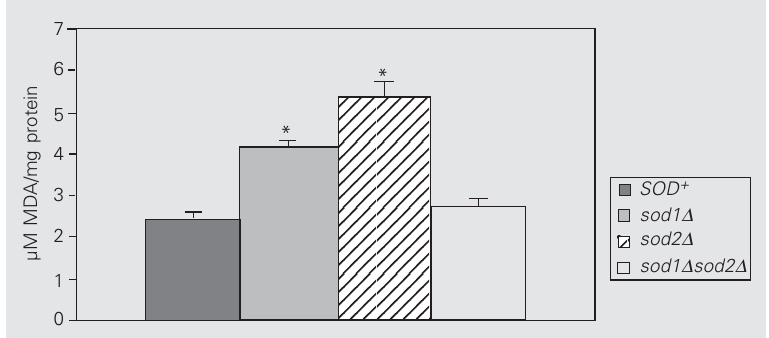
Figure 6. Malondialdehyde (MDA) determination in untreated wild-type and sod mutant cells. Data are reported as the mean ± SD of four independent experiments. *P < 0.05 compared to SOD + (Student t -test).